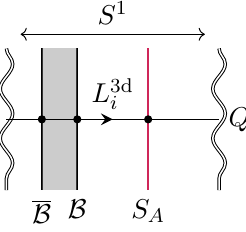
using fund + and its conjugate operator O (cid:3) . The replacement only fund LC fund ; 0 without changing its value. This is why the Wilson fund . fund